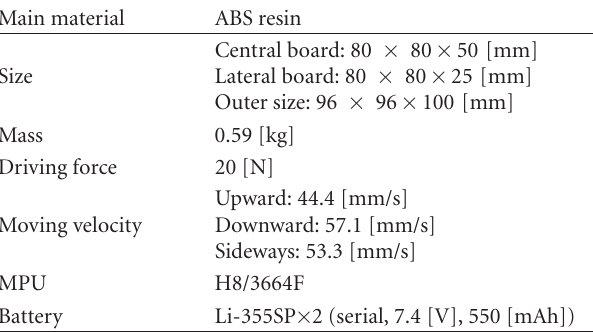
Table 1: Specification of the modules of CHOBIE